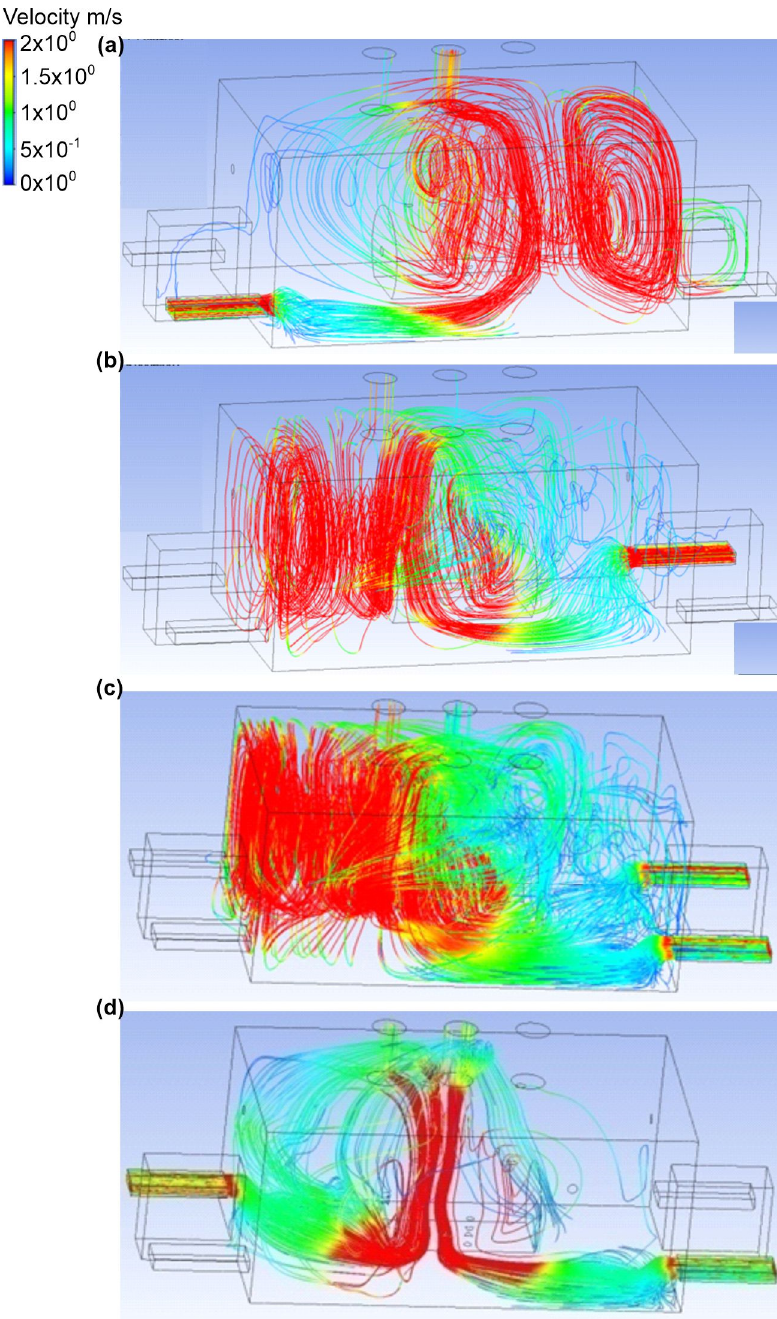
Figure 13. Velocity distribution in the engine room for: ( a ) scenario A, ( b ) scenario B, ( c ) scenario C, and ( d ) scenario D.